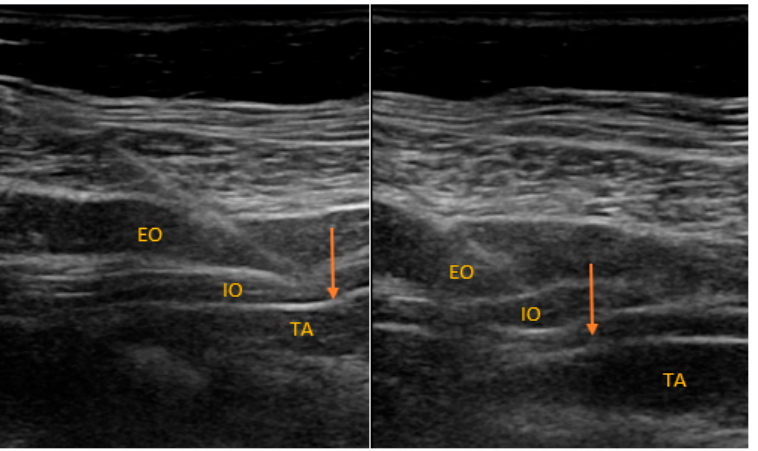
Figure 2. Sonoanatomy of TAPB performed in the study. Figure 1 describes the approach to QLB type 2. EO: external oblique, IO: internal oblique, TA: transversus abdominis, QL: quadratus lumborum. The arrow indicates the needle shaft. Figure 2 describes the approach to TAPB. EO: external oblique, IO: internal oblique, TA: transversus abdominis. The arrow indicates the needle shaft. Figure 3 presents site of administration of QLB (A) and TAPB (B).